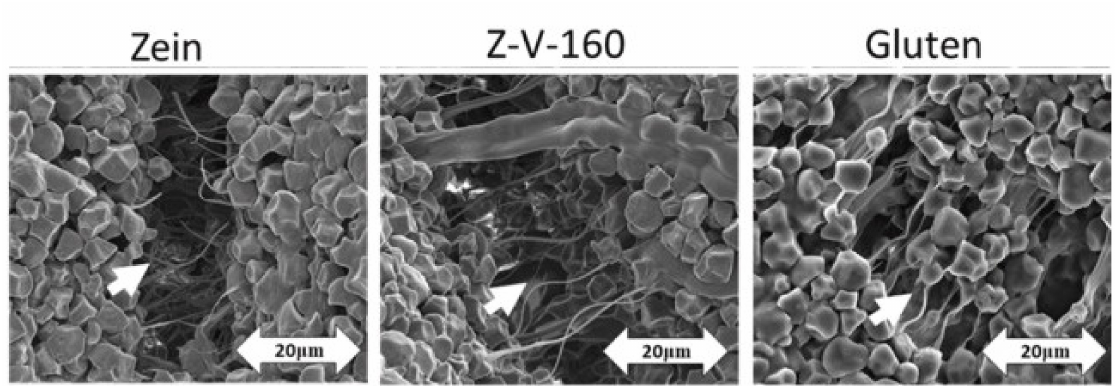
Figure 2. Images of dough samples containing starch with zein, thermally-treated-zein (Z-V-160) and gluten